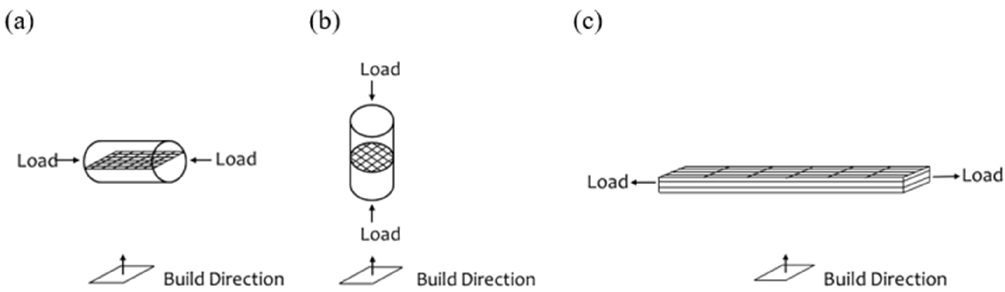
Figure 2. Test Samples Printing Layers Orientation ( a ) Axial Compression ( b ) Transverse Compres- sion ( c ) Axial Tensile